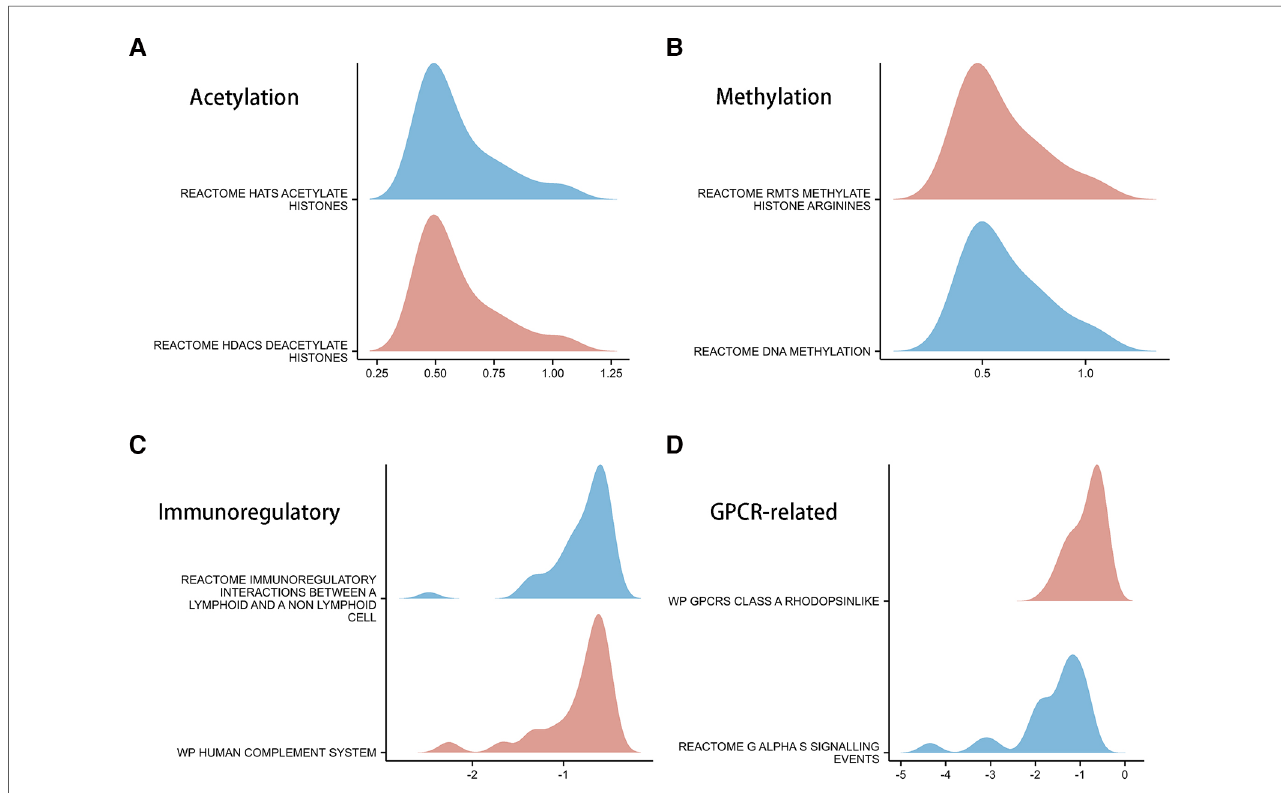
FIGURE 6 GSEA analysis in high- and low-CSRS group. ( A ) Acetylation-related pathways, including HATs acetylate histones and HDACs deacetylate histones. ( B ) Methylation-related pathways, including RMTs methylate histone arginine and DNA methylation. ( C ) Immunomodulatory-related pathways, including immunoregulatory interactions between a lymphoid and a non-lymphoid cell and human complement system. ( D ) GPCR-related pathways, including GPCRs class A rhodopsinlike and G α S signalling